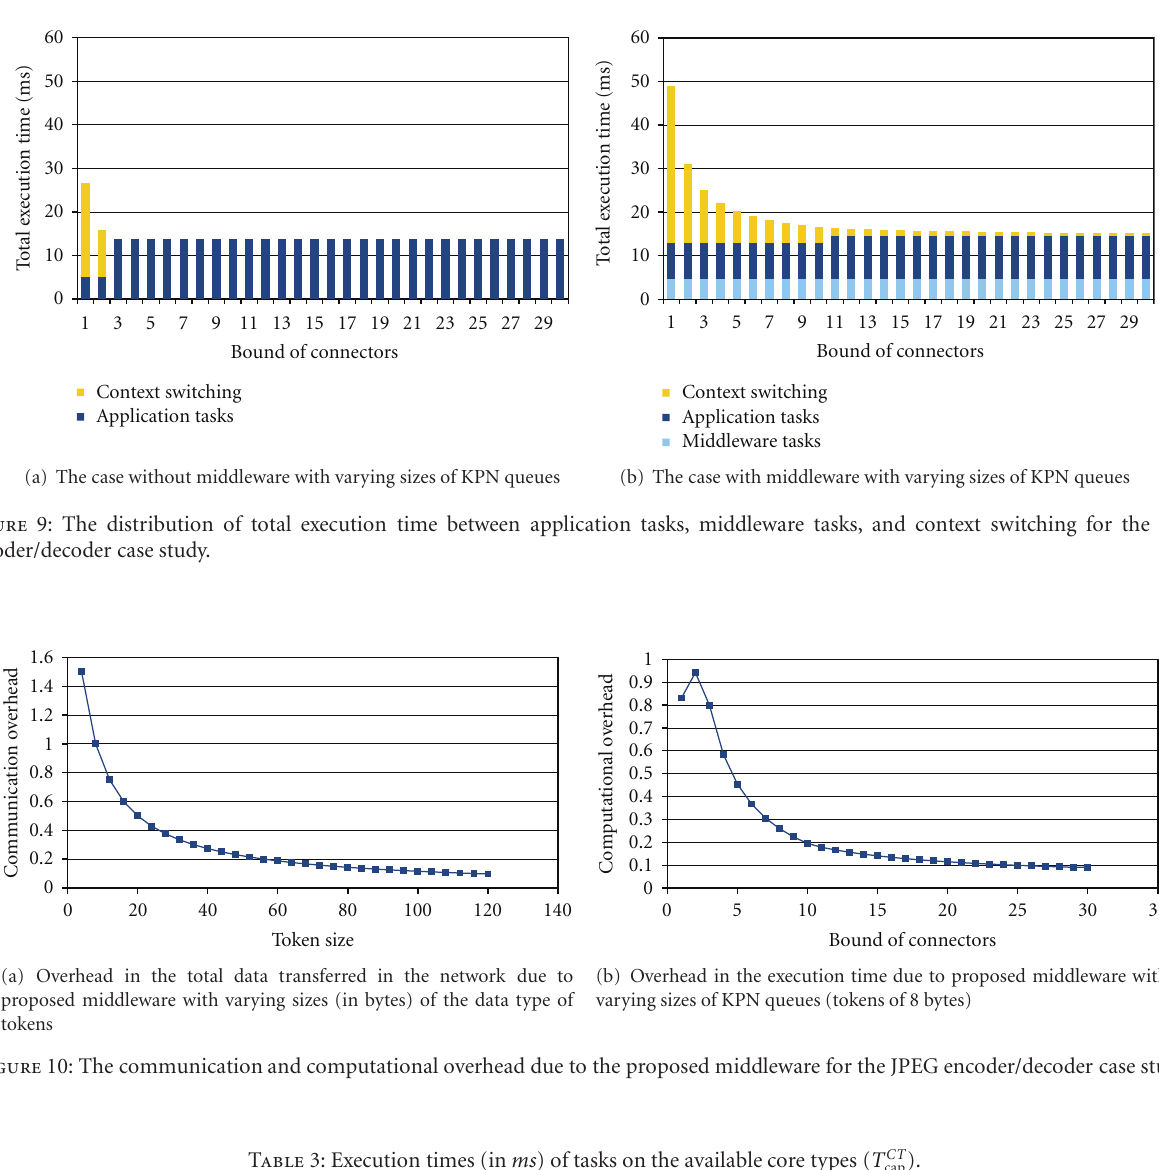
Table 3: Execution times (in ms ) of tasks on the available core types ( T CT